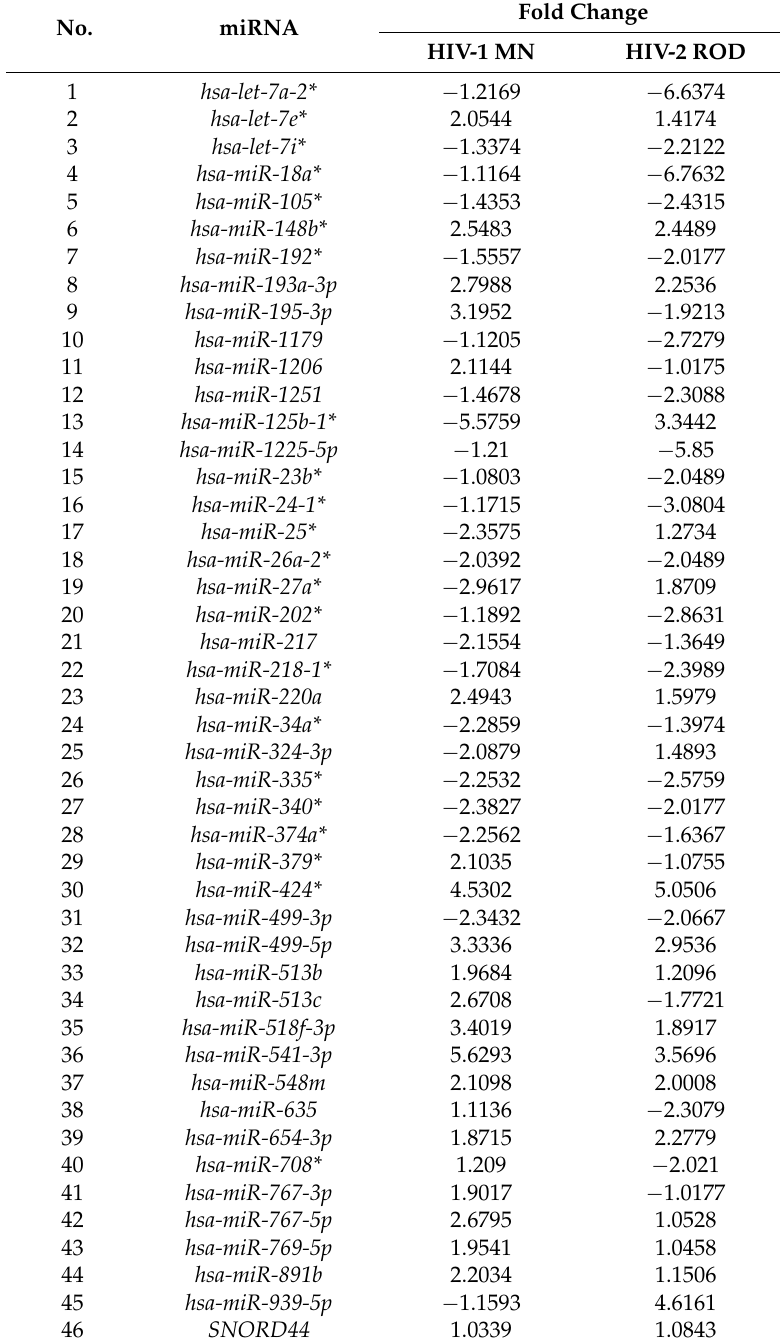
Table 2. Differential miRNA expression in HIV-1 and HIV-2 infected